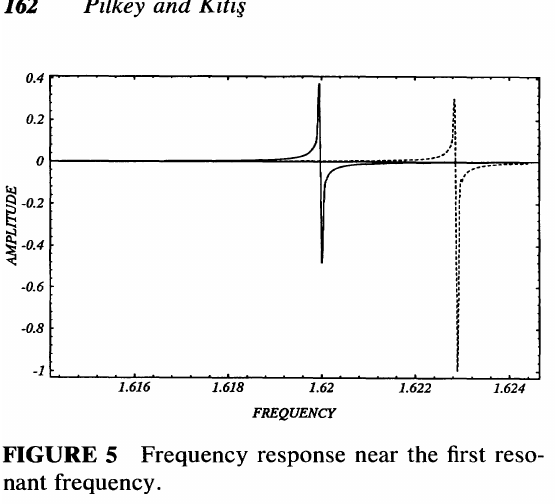
FIGURE 5 Frequency response near the first reso nant frequency.